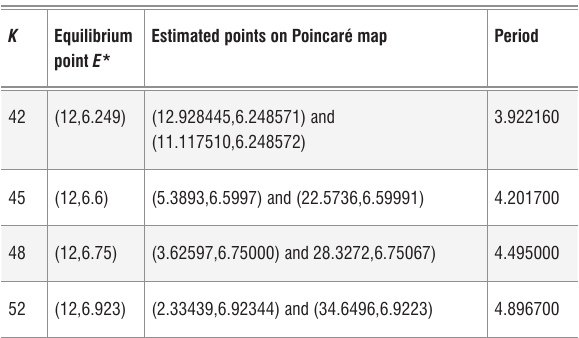
Figure 8: (a) The unique stable limit cycle through the points u* and v* and (b) the time courses of the prey density (solid curve) and predator density (dashed curve) when the model stabilises into a limit cycle.